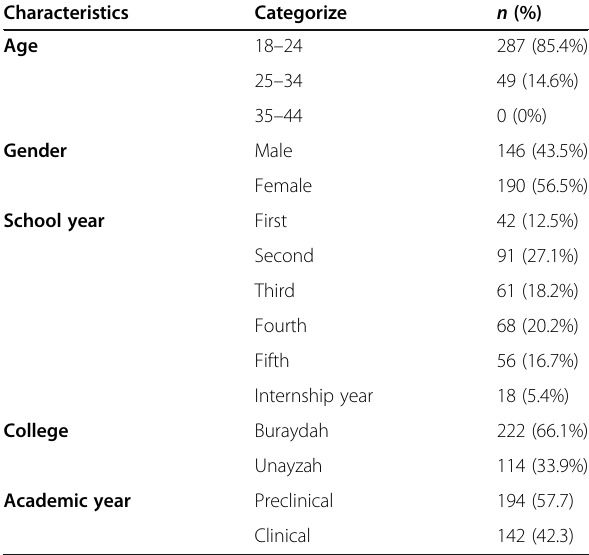
Table 1 Demographic characteristics of the participants ( N =